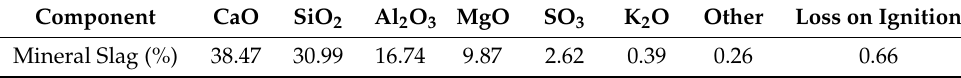
Table 4. The chemical composition of mineral